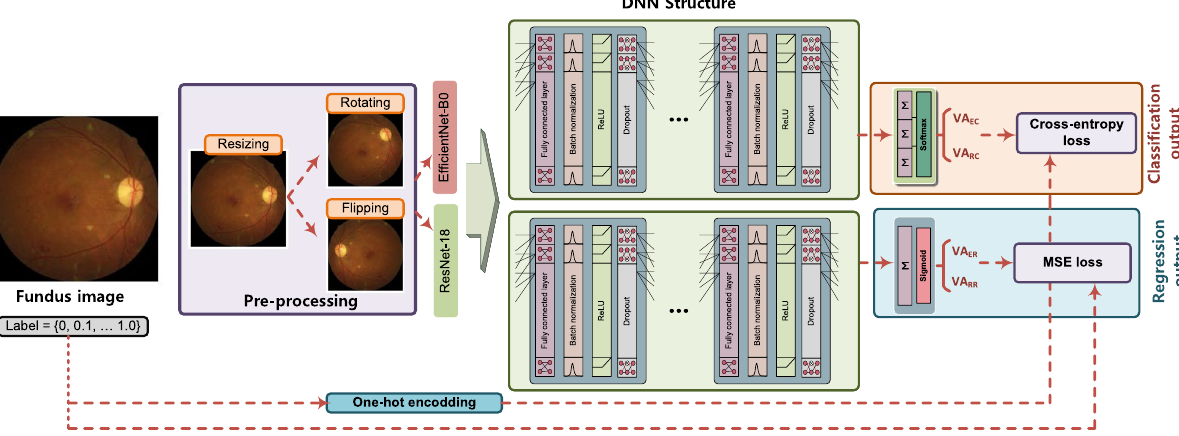
Figure 6. The procedure considered the BCVA estimation scheme. The fundus image was resized to 224 × 224 × 3 , and the random flipping and rotating are applied as a means of data augmentation. The modified fundus images were then fed into pre-trained ResNet-18 and EfficientNet-B0, whose outputs were fed into a DNN structure composed of a fully connected layer, batch normalization, dropout, and ReLU. The softmax function is used as a last layer for classification schemes (i.e., Res-Cla and Eff-Cla) whereas the regression schemes (i.e., Res-Reg and Eff-Reg) employ the sigmoid function instead. The parameters of the considered DNN structure are updated using cross-entropy loss and MSE loss using the level of BCVA as a label for classification schemes and regression schemes,